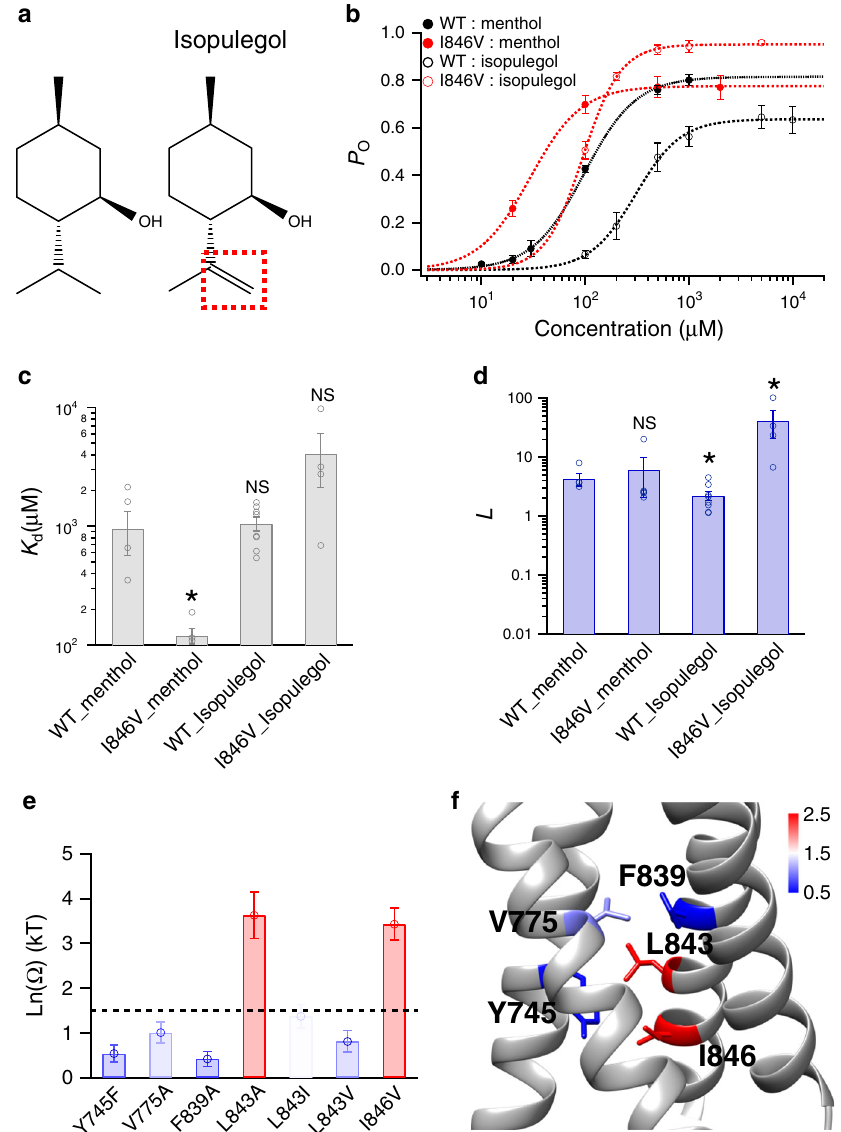
Fig. 4 Speci fi c interactions between menthol isopropyl legs and the channel probed with isopulegol. a Chemical structures of menthol and isopulegol. The isopropyl group in menthol is replaced by the methylethenyl group in isopulegol (dashed box in red). b The concentration – response curves of wild type and mutant such as I846V with either menthol or isopulegol were measured with whole-cell patch-clamp recordings ( n = 3 – 5). c , d For wild type and I846V channel, K d and L values were calculated from the concentration – response curves in c (two-sided t -test, * p < 0.05; NS not statistically signi fi cant). e Summary of coupling energy measurements. Coupling energy value was calculated from the K d values. Mutants showing a coupling energy larger than 1.5 kT (dashed line) were colored in red. Those with less energy were colored in different shades of blue. At least four independent trials were performed for each chemical at each concentration. f Spatial distribution of coupling energy values within the menthol-binding pocket. Color scheme is the same as in e . Color scale is in the unit of kT. g Structural fl uctuation in the menthol-bound S1 – S4 domain during 378 ns molecular dynamic simulation. Root-mean- square deviation (RMSD) of protein structures was calculated as compared to our menthol docking model. h Ensemble plot of the menthol molecule (dashed box in yellow) with snapshots of the simulation from the beginning to the end (red and blue, respectively). A snapshot was saved every 10 ns during the simulation. All statistical data are given as mean ± s.e.m. Source data are provided as a Source Data fi mutant cycle analysis with isopulegol (Fig. 4 b – d) and observed with isopulegol was very similar to that measured with 3- large coupling energy values at L843 and I846 sites (Fig. 4e). A methylcyclohexanol (Figs. 4f and 3h, respectively), so we believe coupling energy larger than 1.5 kT predicts that the distance that our thermodynamic mutant cycle analysis with menthol and between interacting parties is less than 4 Å 24 . Indeed, our docking its analogs is robust to probe ligand – protein interactions. results showed the carbon atoms in the isopropyl group of menthol are about 3.53 and 3.66 Å from the sidechains of I846 Menthol-induced conformational changes revealed by ANAP . and L843 (C9 atom of menthol to CD1 atom of I846: 3.53 Å; C8 Our thermodynamic mutant cycle analysis and computational atom of menthol to CB atom of L843: 3.66 Å), respectively studies above have revealed that menthol employs a “ grab and (Fig. 1e). The spatial distribution of coupling energy measured stand ” mechanism to bind with TRPM8 through its hydroxyl